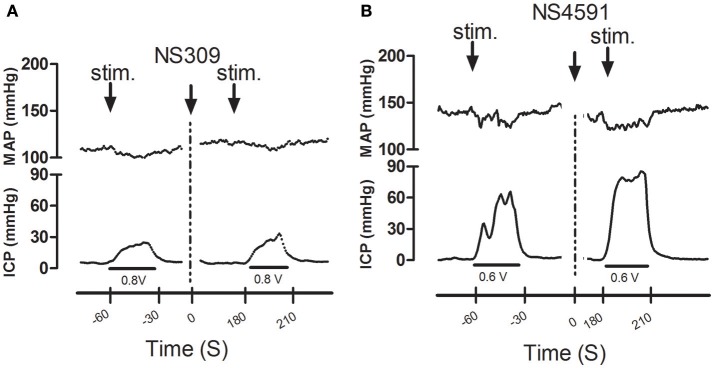
Original recordings showing the effect of NS309 and NS4591 on mean arterial pressure (MAP) intracavernous pressure (ICP) in rat penis. The upper traces show mean arterial pressure (MAP) and the lower traces the changes in intracavernous pressure (ICP) induced by submaximal stimulation of the cavernous nerve before and 3 min after (A) NS309 and (B) NS4591 in the rat.